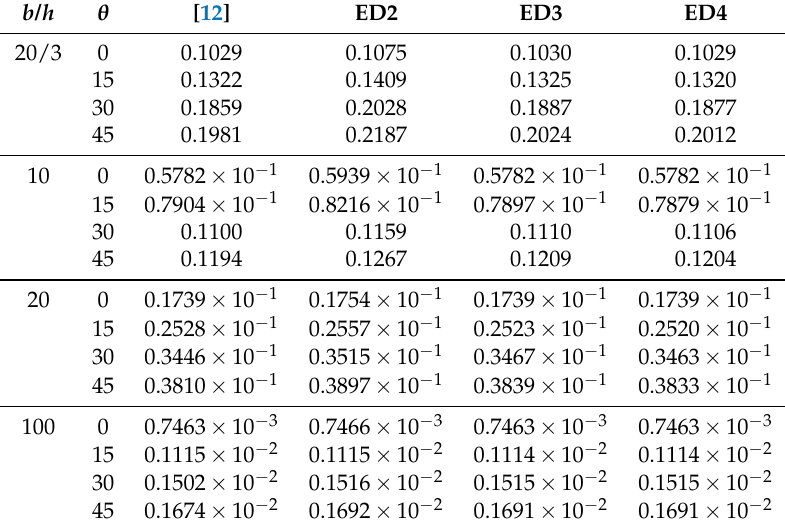
Table 1. Non-dimensional buckling temperatures T cr α 0 for SSSS straight-fiber laminates using 12 × 12